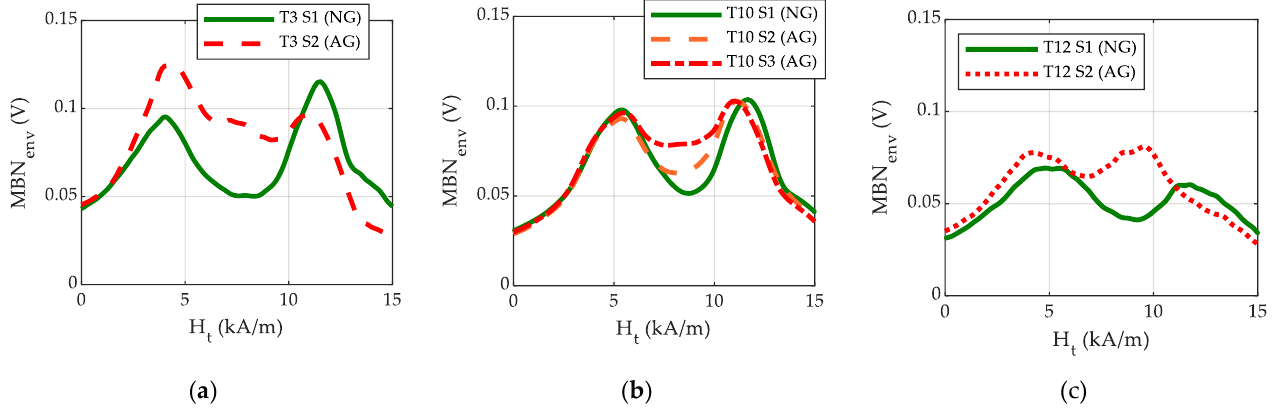
Figure 7. MBN envelopes measured with medium frequency excitation (System 1) of ball screw shafts representative of different heat treatments with varying hardened layer depth (LD): ( a ) T3 (LD ≈ 500 µ m) ( b ) T10 (LD ≈ 1100 µ m) and ( c ) T12 (LD ≈ 1250 µ